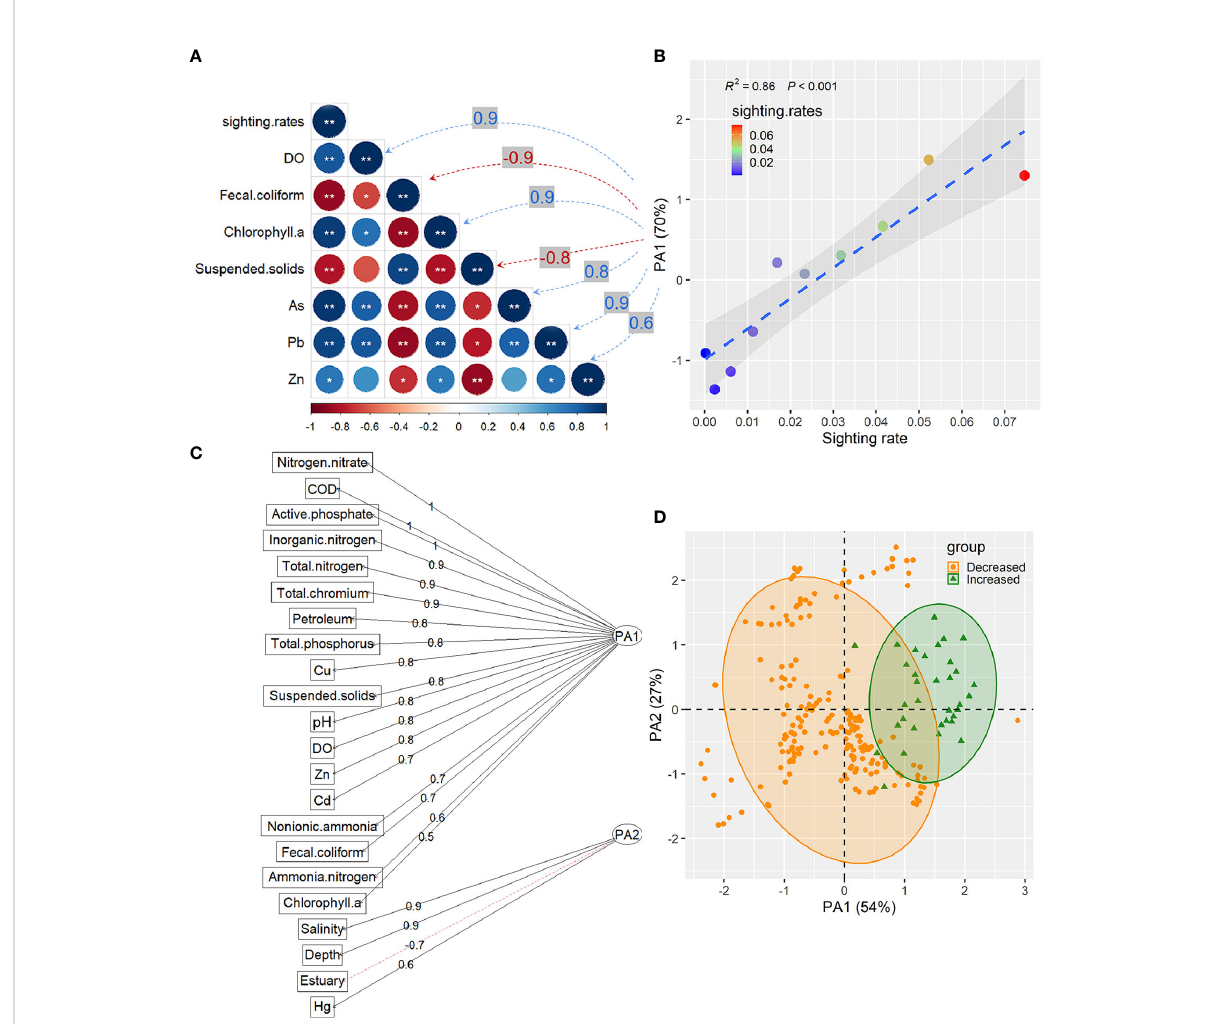
FIGURE 4 Factor analysis plot of water quality indicators in different Indo-Paci fi c Humpback dolphin habitats. (A) Correlation matrix between seven factors and dolphin sighting rates (sightings/surveys/km 2 ); (B) Linear fi tting of dolphin sighting rates with Pa1 obtained through parallel analyses; (C) Correlation of water quality indicators with signi fi cant differences between the declined dolphin sighting rates and increased habitat areas and two factors (Pa1 and Pa2) obtained through parallel analyses; (D) Factor analysis plot based on the scores of Pa1 and Pa2 from the evaluation of the declined dolphin sighting rates and increased